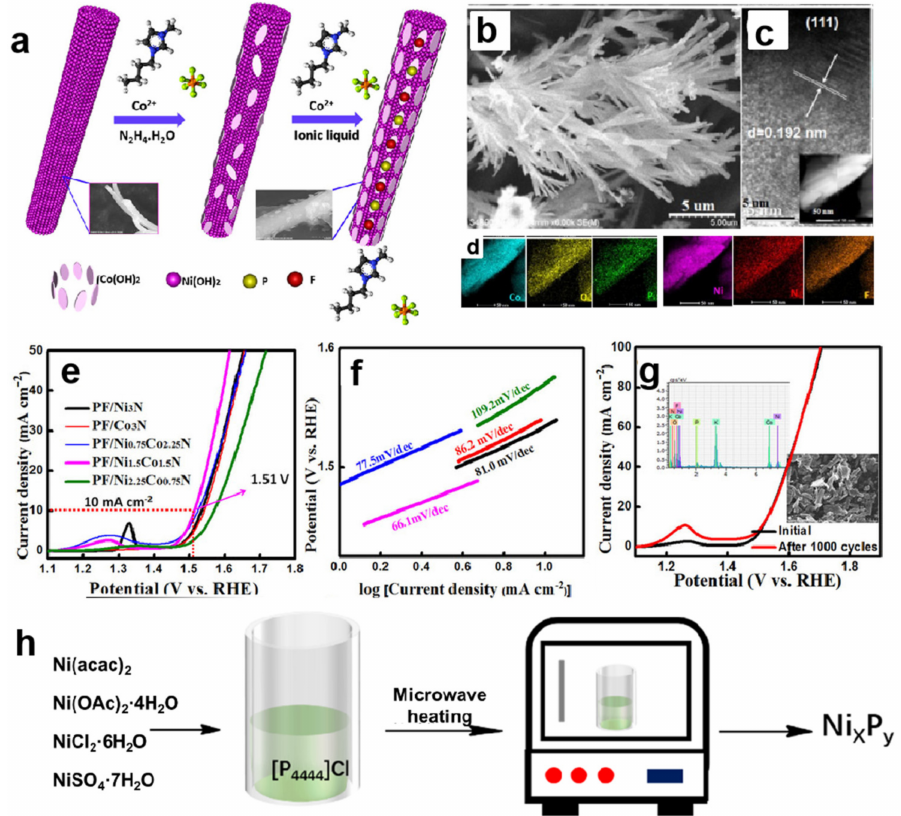
Figure 3. Schematic illustration of the fabrication processes of PF/Ni 1.5 Co 1.5 N ( a ), SEM image ( b ), HR- TEM image (inset: the corresponding HAADF-STEM) ( c ) and mapping results ( d ) of PF/Ni 1.5 Co 1.5 N, polarization curves ( e ) as well as Tafel slopes ( f ) of PF/Ni 1.5 Co 1.5 N and the comparative catalysts for OER in alkaline solution, LSV curves and morphology of the PF/Ni 1.5 Co 1.5 N catalyst before and after CV testing of 1000 cycles ( g ) (Reprinted with permission from Ref. [44], 2017, Wiley); Schematic diagram to prepare nickel phosphide in [P 4444 ]Cl IL ( h )